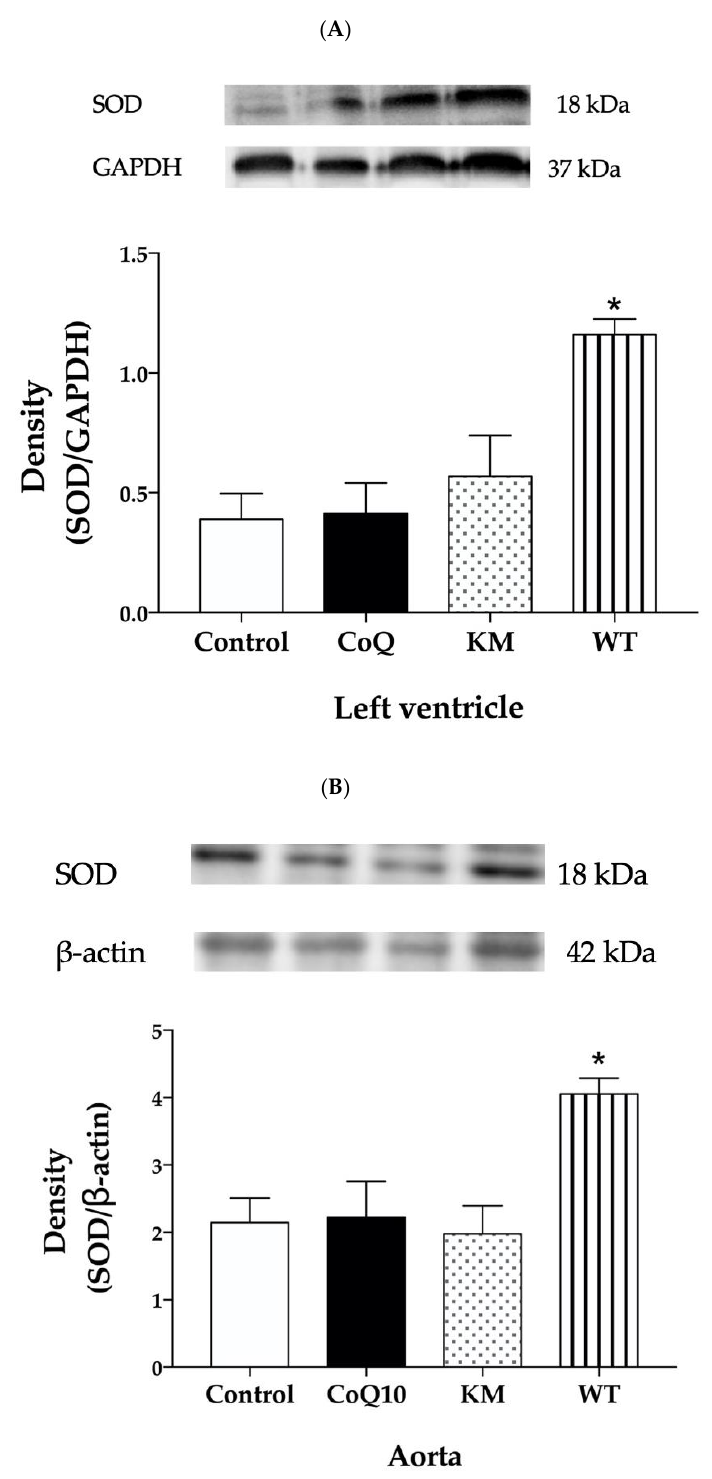
Figure 3. Effect of CoQ10, KM, and WT on SOD protein expression in the left ventricle (LV) ( A ) and aorta ( B ). CoQ10—coenzyme Q10, KM—Koralovij Marka, WT—Wild Type. Data are means ± SEM from 6 animals in each group. * p < 0.001 compared to the control group.